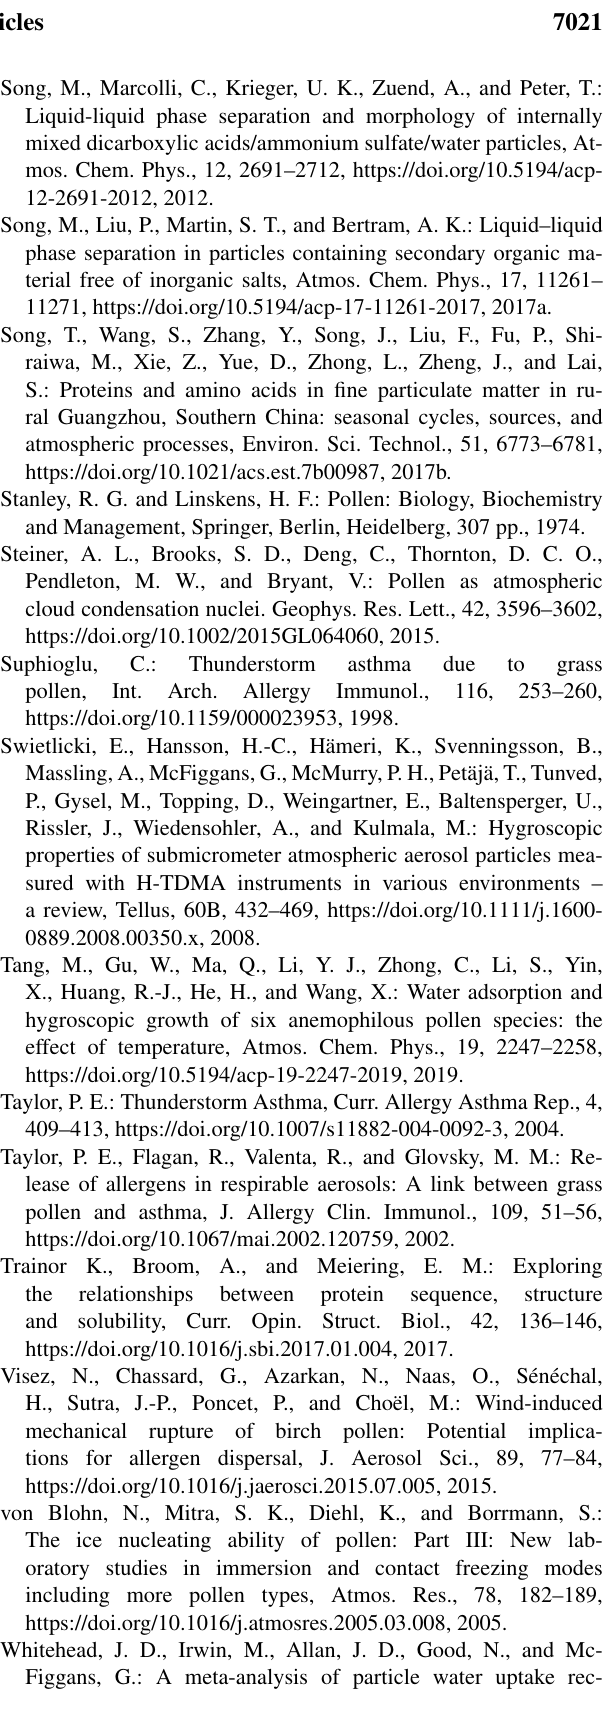
Figgans, G.: A meta-analysis of particle water uptake